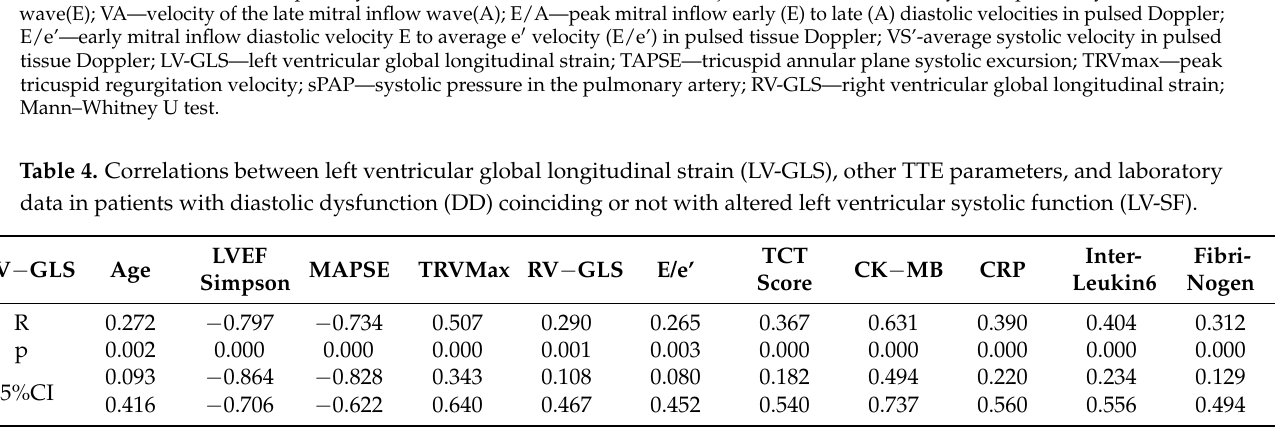
Table 3. Transthoracic echocardiography (TTE) parameters determined in the study group. Patients without DD and Characteristics Normal LV-SF n = 93 (74.4%)